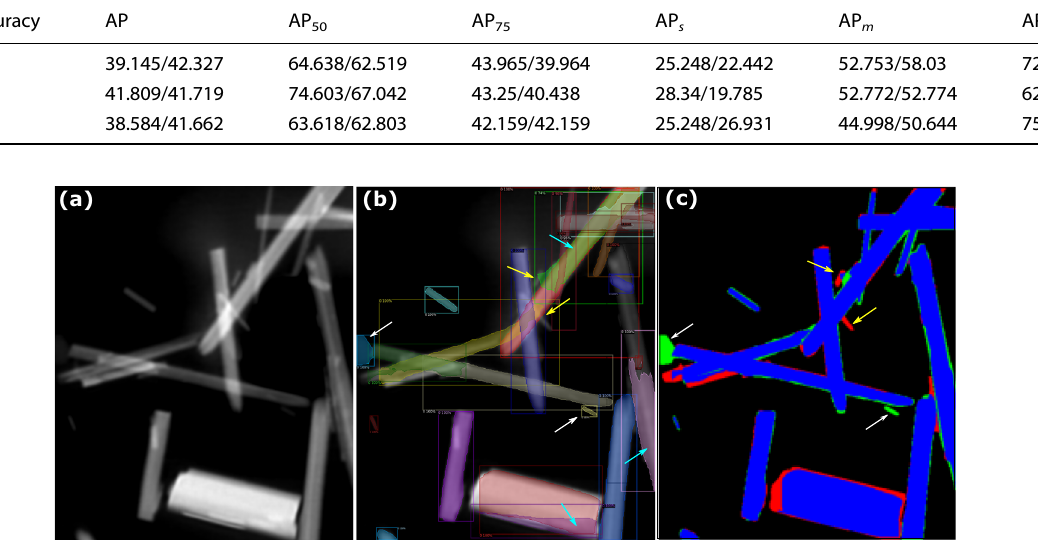
Fig. 4 Model prediction on V 2 O 5 nanowires within the X-ray pytchography image (531 × 449 pixels). a Test image. b Predicted instance masks with lower opacity plotted on the test image. The best performer in AP segmentation mask in Table 2 was used to visualize the prediction masks in b . c Semantic binary mask. Blue: TP, Red: FN, Green: FP; yellow arrows indicate the main FN pixels, i.e., nanowire pixels missed by the model. White arrows indicate the FP pixels, which were overlooked in the manual annotation, but detected by the model. Cyan arrows indicate over-predicted pixels, of which the model predicts them as additional nanowires, but were only regions of higher